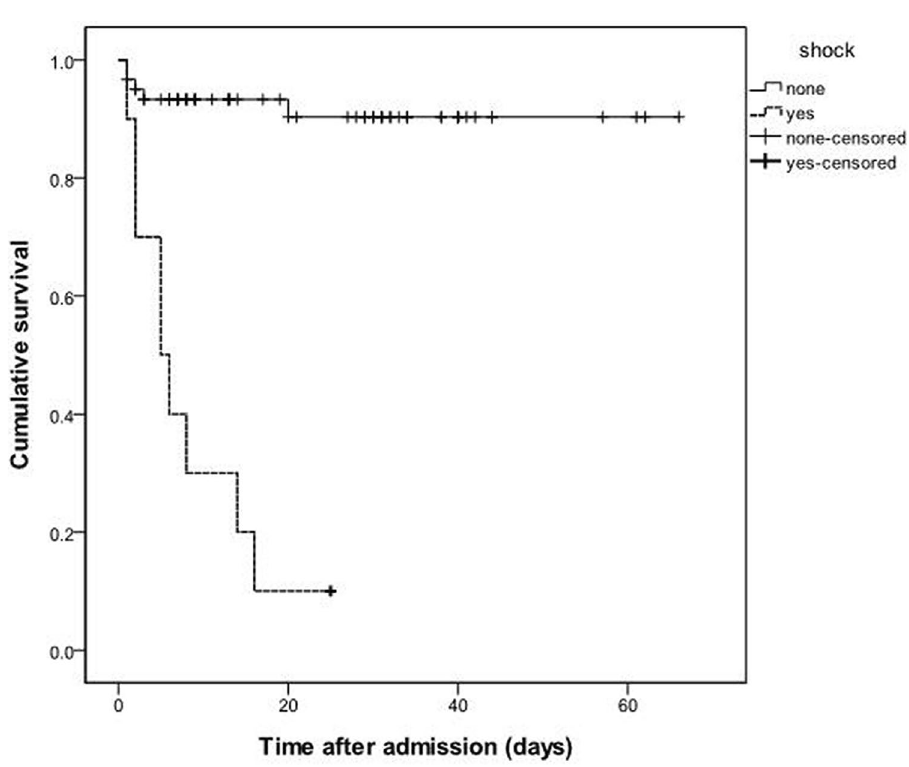
Figure 1. Kaplan–Meier analysis. Patients with shock suffered lower cumulative survival than patients without shock (log-rank test, chi-square = 42.704, P <